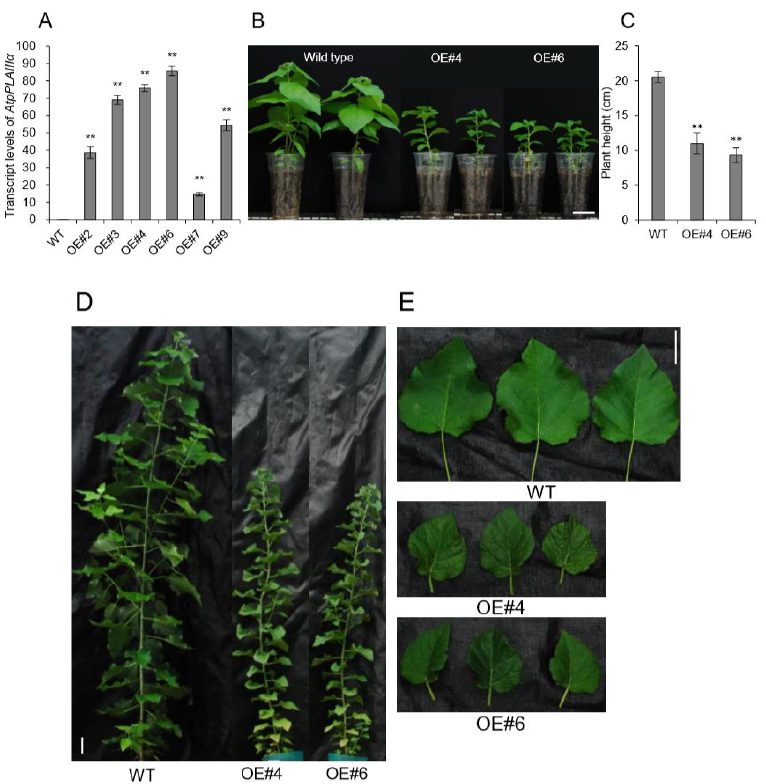
Figure 4. Overexpression of AtpPLAIIIα in poplar resulted in a dwarf phenotype. ( A ) Transcript level of AtpPLAIIIα in WT and AtpPLAIIIα-OE poplars; n = 3. ( B ) Growth phenotype and ( C ) plant height of 3-month-grown poplars (WT, n = 10; OE, n = 5). ( D and E ) Six-month-grown poplar tree phenotypes in WT and OE lines. Bars = 5 cm. Data represent the mean ± SE of three independent replicates at P < 0 . 01 (**).